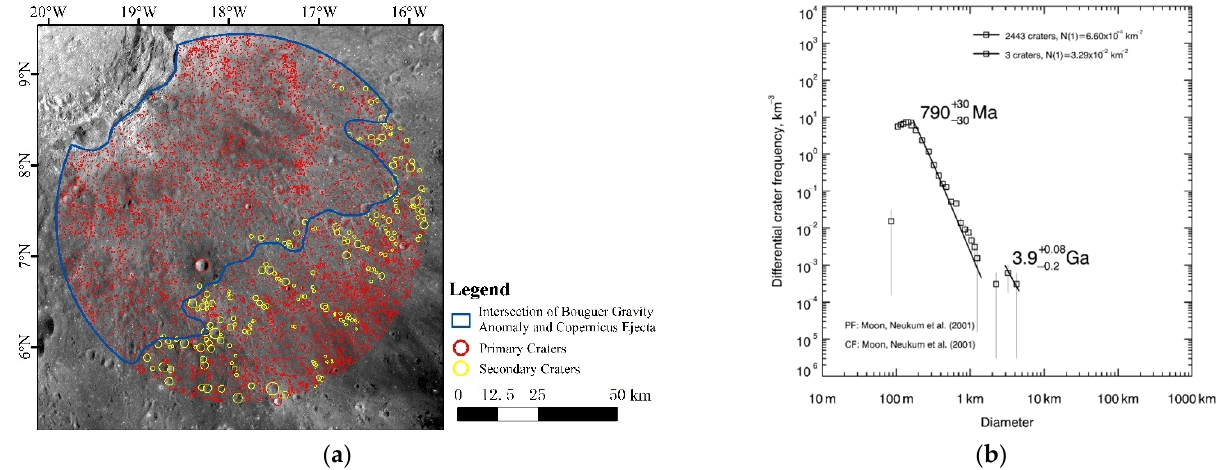
Figure 6. Bouguer gravity anomaly CSFD dating. ( a ) Primary craters (red) and secondary craters (yellow) in the intersection of the Copernicus ejecta and the Bouguer gravity anomaly (blue); ( b ) Differential crater frequency and geologic time of the Bouguer gravity anomaly.